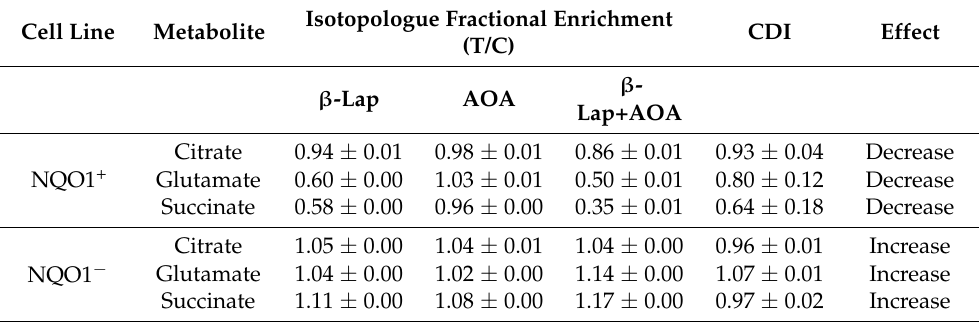
Table 1. Synergistic effects in MDA-MB-231 NQO1 + and NQO1 − breast cancer cells determined by CDI